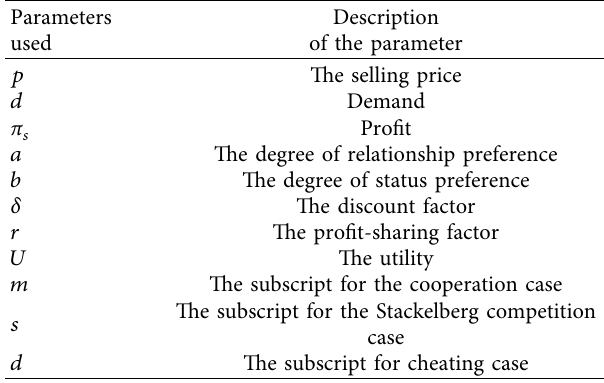
Table 1: Notation